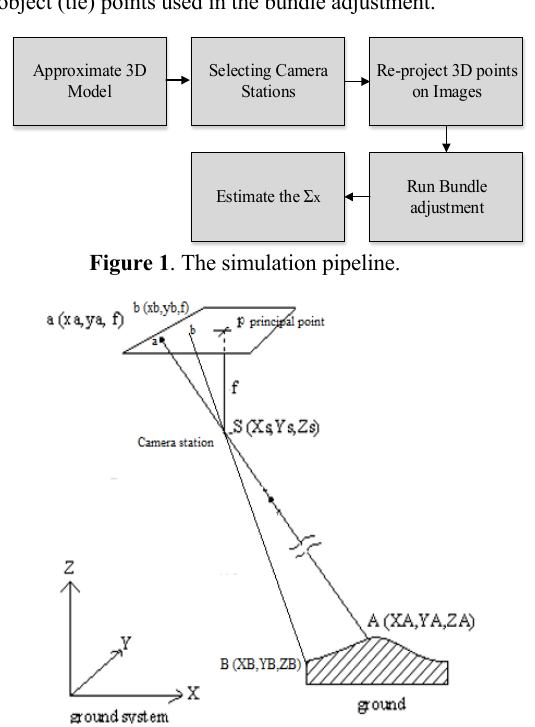
Figure 1 . The simulation pipeline.